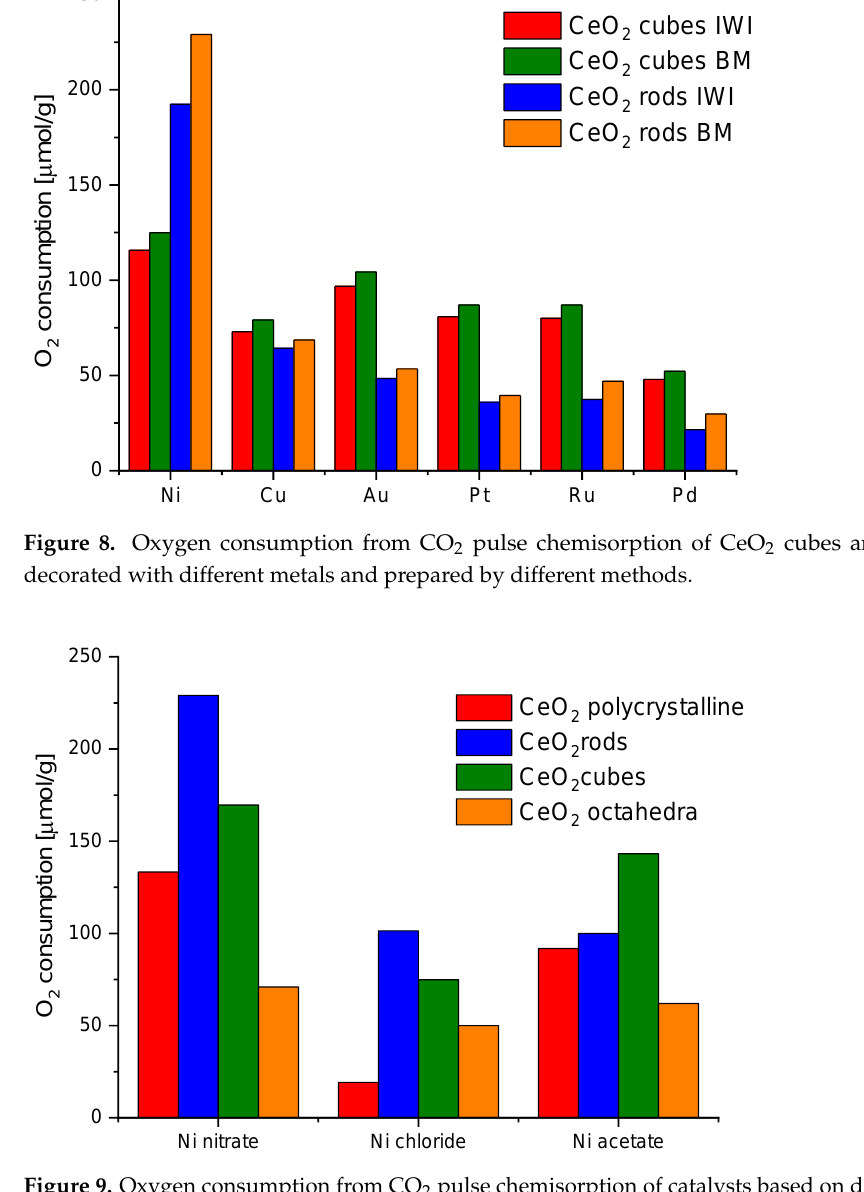
Figure 9. Oxygen consumption from CO 2 pulse chemisorption of catalysts based on different shapes of CeO 2 and different nickel salt.